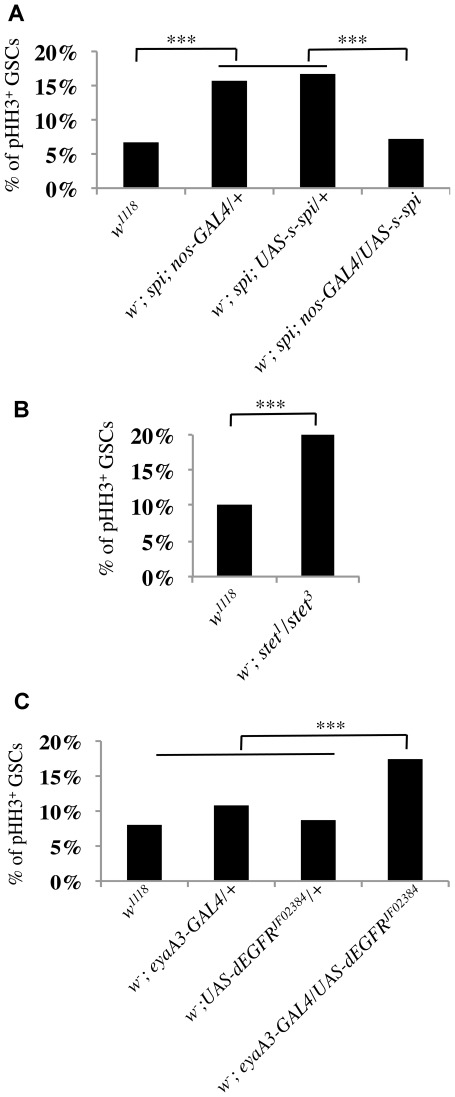
EGF signaling from the germline to the soma decreases the frequency of GSC divisions.(A–C) The percentage of pHH3-positive GSCs for each indicated genotype. (A) The expression of s-spi in germ cells rescues the hyper-proliferation of GSCs in spi77-20 testes. (B) GSCs in stet1/stet3 testes showed an increased M-phase index compared to w1118 testes. (C) RNAi-mediated knock-down of EGFR in the soma causes a higher GSC M-phase index, ***p-value≤0.0001.